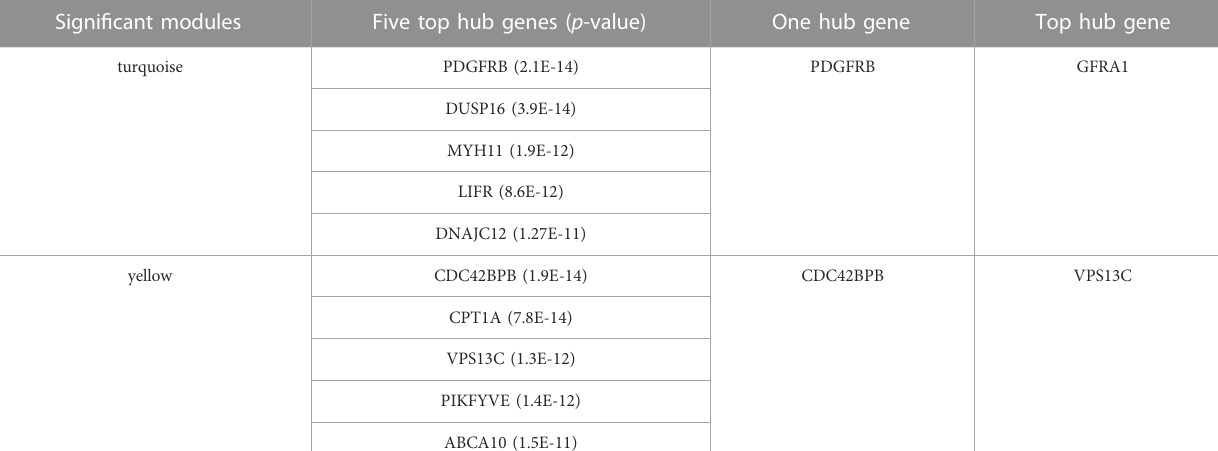
TABLE 3 ( Continued ) Top fi ve hub genes, Top hub, and One hub genes in signi fi cant modules for acute heat stress.